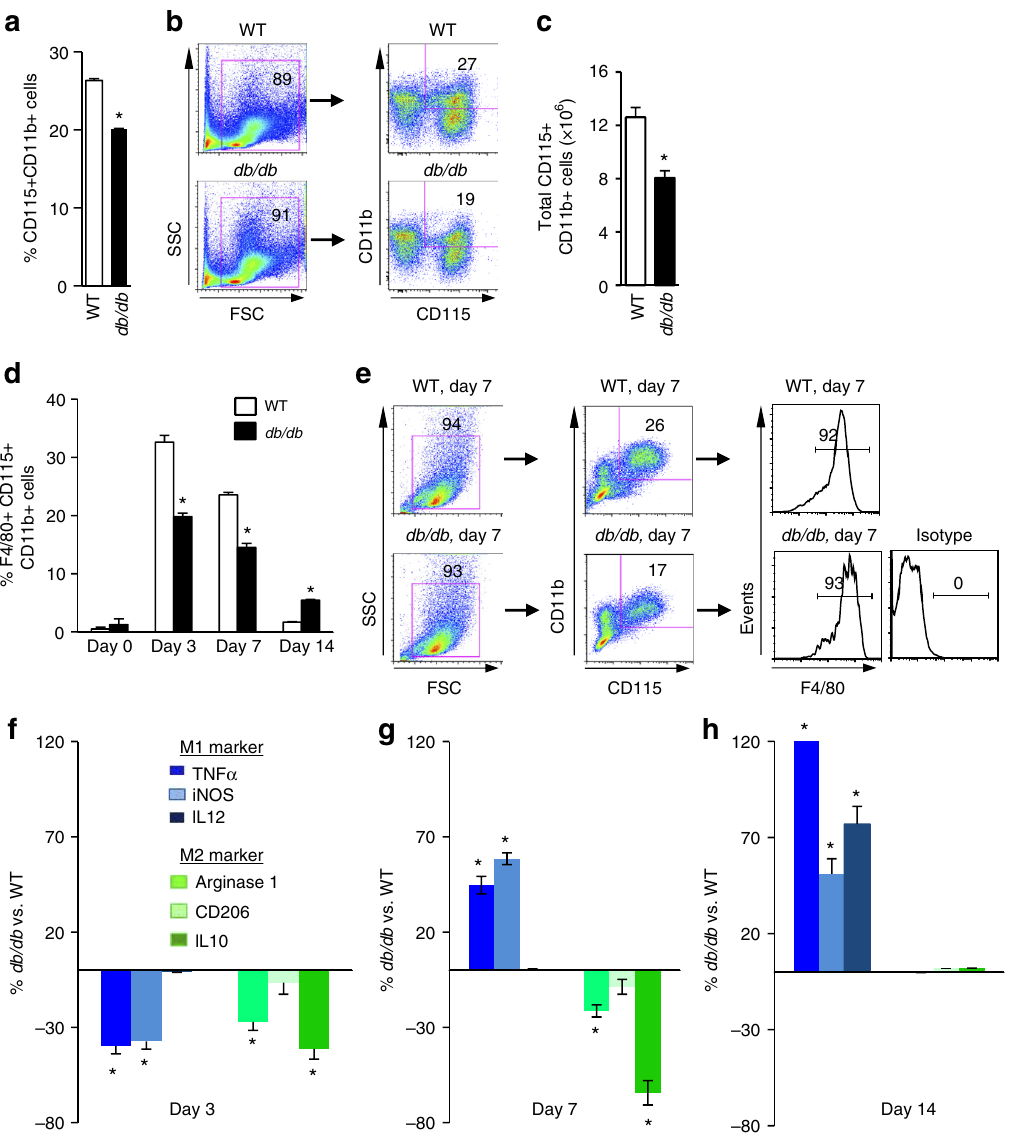
Fig. 2 Type 2 diabetes reduces macrophage in fi ltration into wounds. a Quanti fi cation of monocytes concentration in bone marrow by fl ow cytometry ( n = 6, * p < 0.05 vs. WT). b Schematic of fl ow cytometry gating. c Quanti fi cation of absolute number of monocytes in bone marrow ( n = 6, * p < 0.05 vs. WT). d Quanti fi cation of macrophage concentration in the cutaneous wounds by fl ow cytometry ( n = 6, * p < 0.05 vs. WT). e Schematic of fl ow cytometry gating. f – h Quanti fi cation of M1/M2 polarization in the cutaneous wounds by fl ow cytometry ( n = 6, * p < 0.05 vs. WT). Results are expressed as means ± SEM. Two-tailed unpaired Student ’ s t test was used for a , c , d , f , g , h region (labeled as Dnmt1 in Fig. 5b) and determined the luciferase HSCs was downregulated following the addition of an shRNA against Dnmt1 (Fig. 6a; Supplementary Fig. 9a, b). Under in vitro conditions, the knockdown of Dnmt1 in db/db HSCs consistently increased their differentiation towards monocytes/ macrophages (Supplementary Fig. 9c, d). WT recipients reconstituted with Dnmt1-knockdown db/db HSCs showed a signi fi cantly higher rate of wound healing than WT recipients reconstituted with db/db HSCs (Fig. 6b, c, d, e). In WT mice reconstituted with Dnmt1- knockdown db/db HSCs, the in fi ltration of monocytes/macro- phages, as well as their M1/M2 polarization throughout the three phases of wound healing, were restored to levels comparable to those in WT mice reconstituted with WT HSCs (Fig. 6f, g, h, i). These fi ndings indicate that sustained upregulation of Dnmt1 expression in HSCs mediates the deleterious effects of T2DM on wound healing by inhibiting their differentiation towards mono- cytes/macrophages and skewing them toward M1 polarization. | DOI: 10.1038/s41467-017-02425-z |